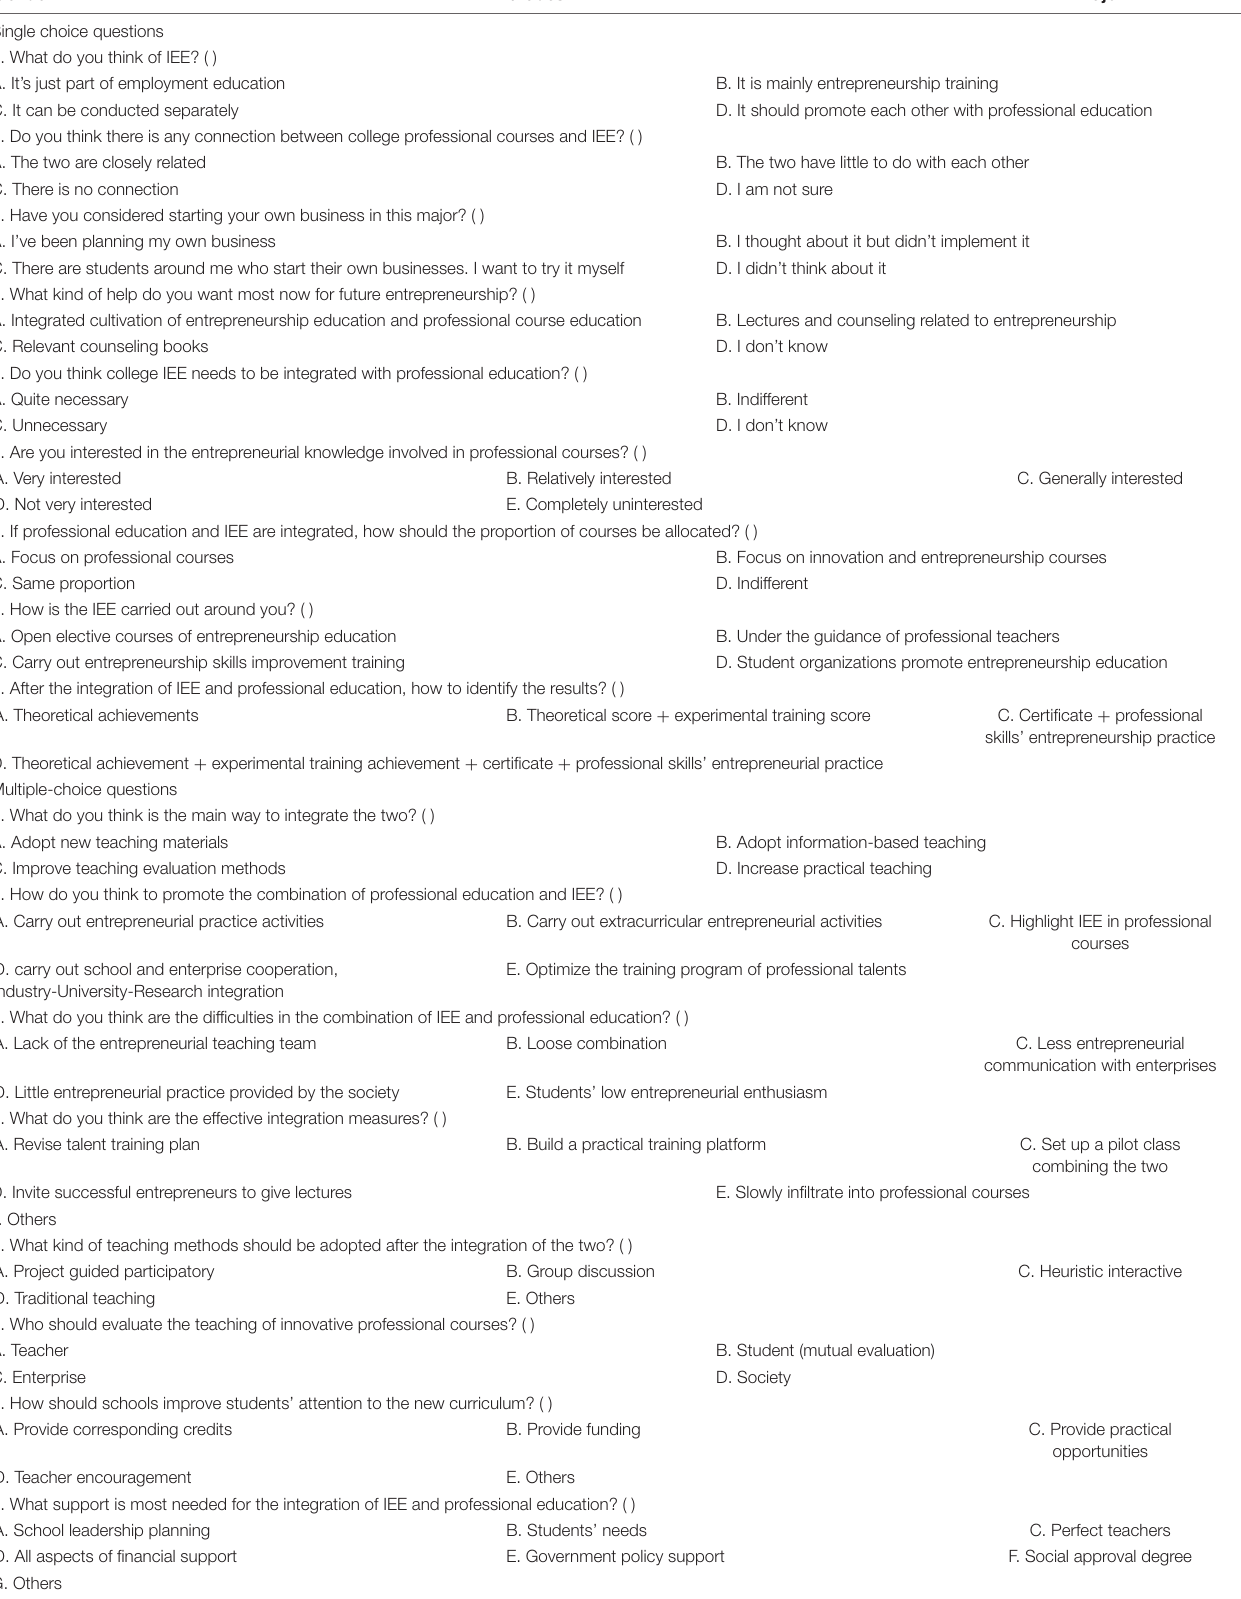
TABLE 1 | Questionnaire on the integration of innovation and entrepreneurship education (IEE) and professional curriculum education. Gender Grades